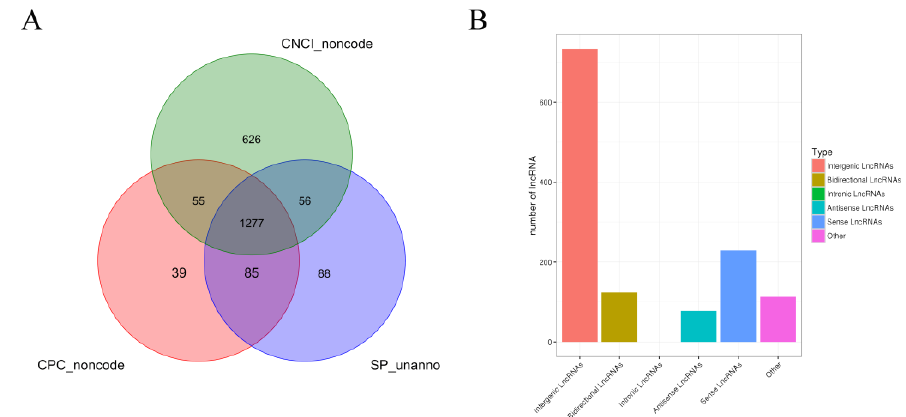
Figure 1. Identification and analysis of lncRNA. Note: ( A ) Venn diagram of annotation results of CPC, CNCI, and Swissprot. ( B ) Statistical chart of new lncRNA transcript types.